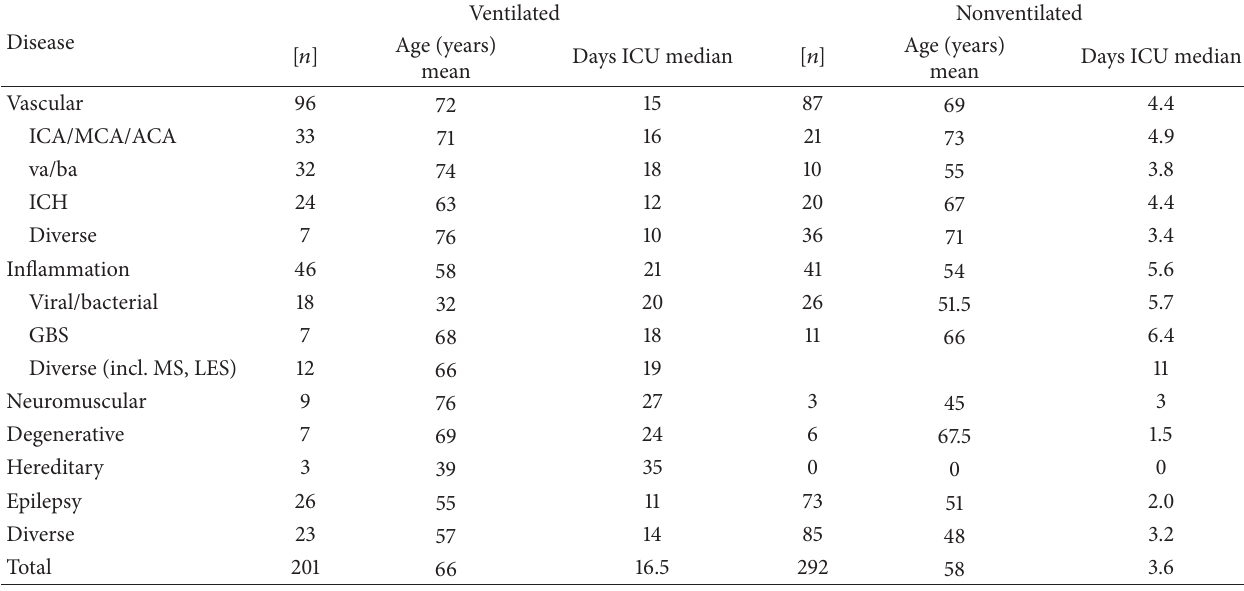
Table 1: Comparison of ventilated versus nonventilated patients and different diseases.